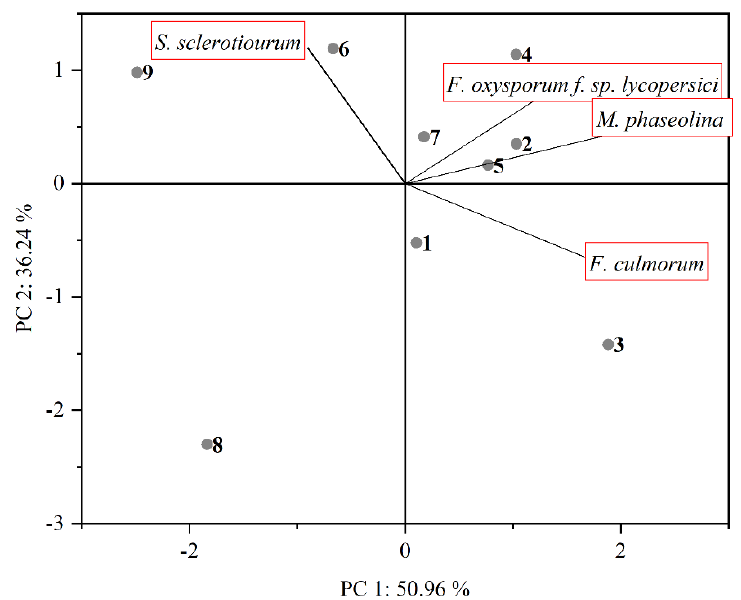
Figure 1. Biplot graph with first two principal components for the plant pathogenic fungi and com- pounds.